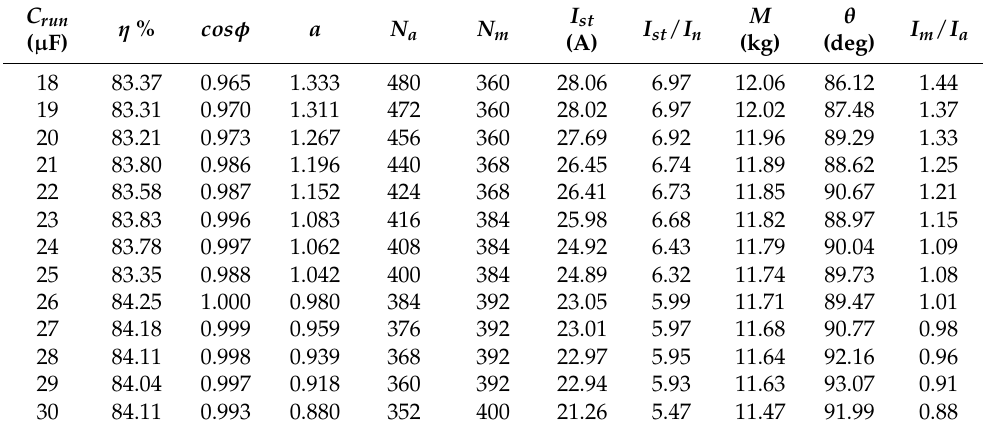
Table 8. Design parameters and performance quantities of the SPIMs with rotor bars of drop